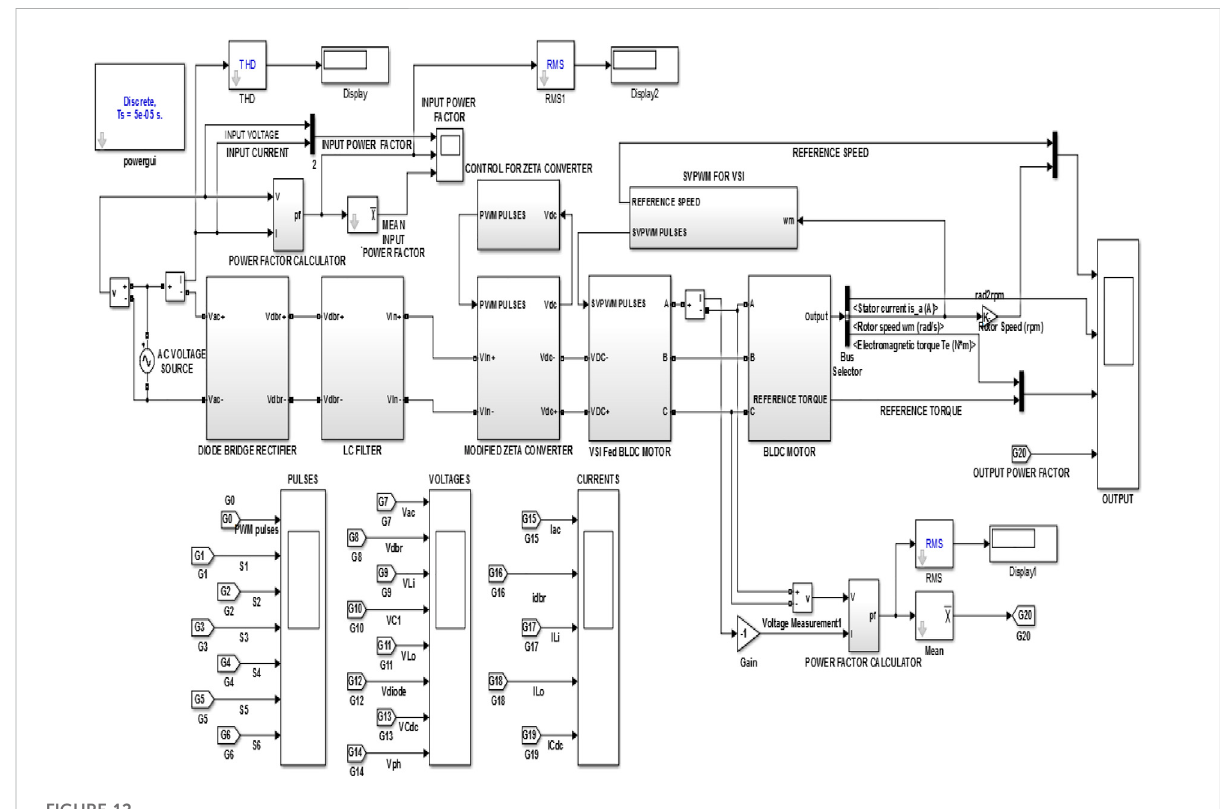
FIGURE 12 MATLAB/Simulink model of the proposed